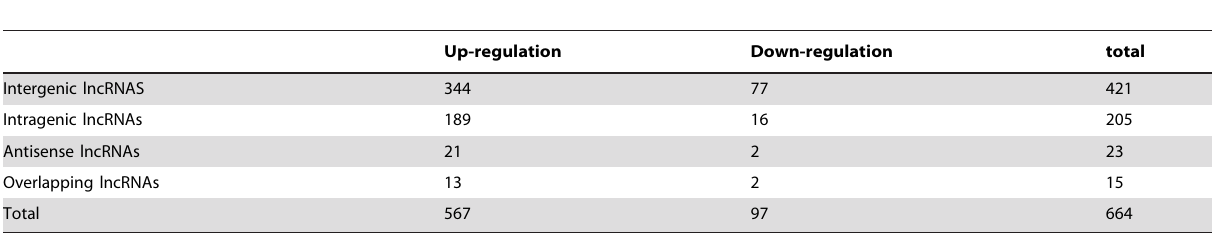
Table 1. Identification and expression analysis of lncRNAs responding to drought